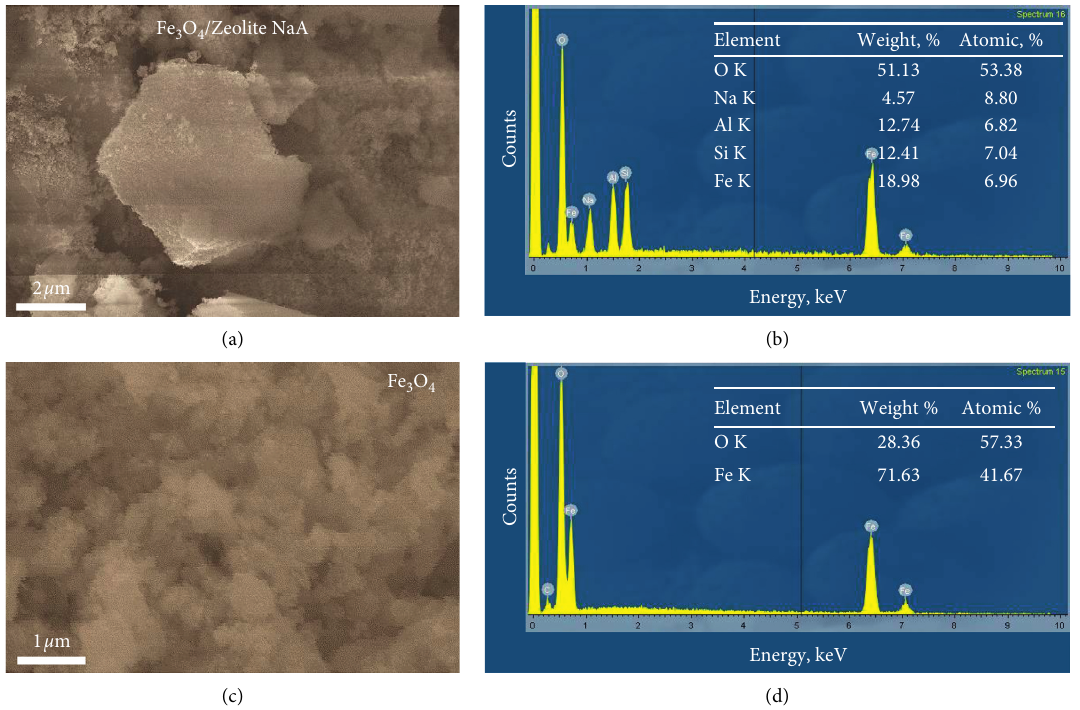
Figure 5: FESEM images and EDX spectra of 3.3% Fe 3 O 4 /ZA nanocomposite (a, b) and Fe 3 O 4 NP (c, d) samples,